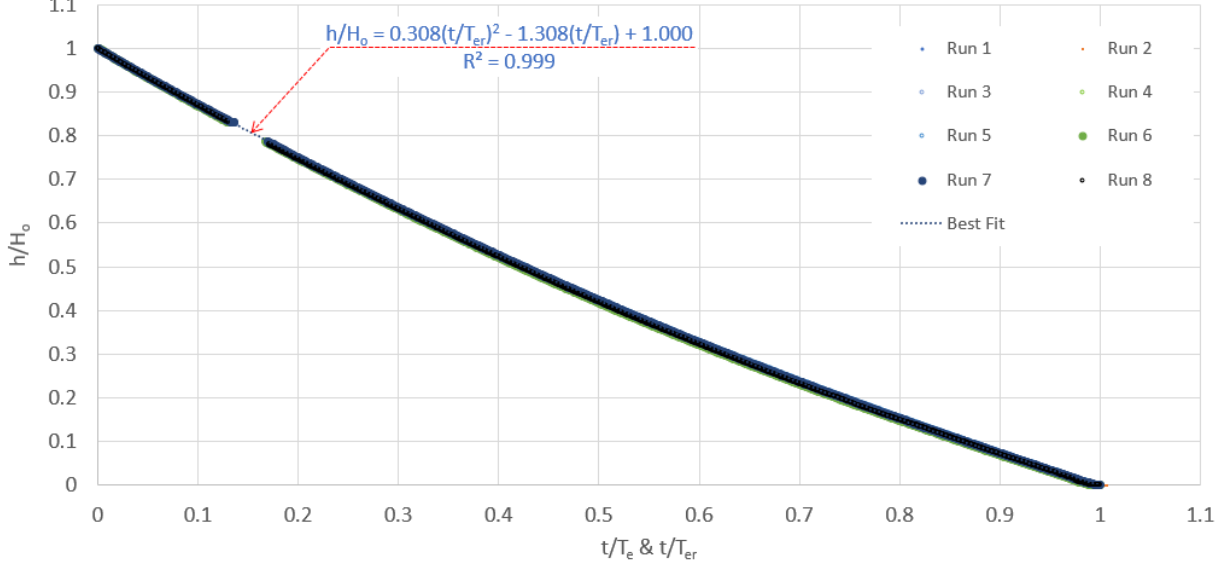
Figure 8. The temporal decline trends for the normalized tank water depth with respect to time (with rotor).